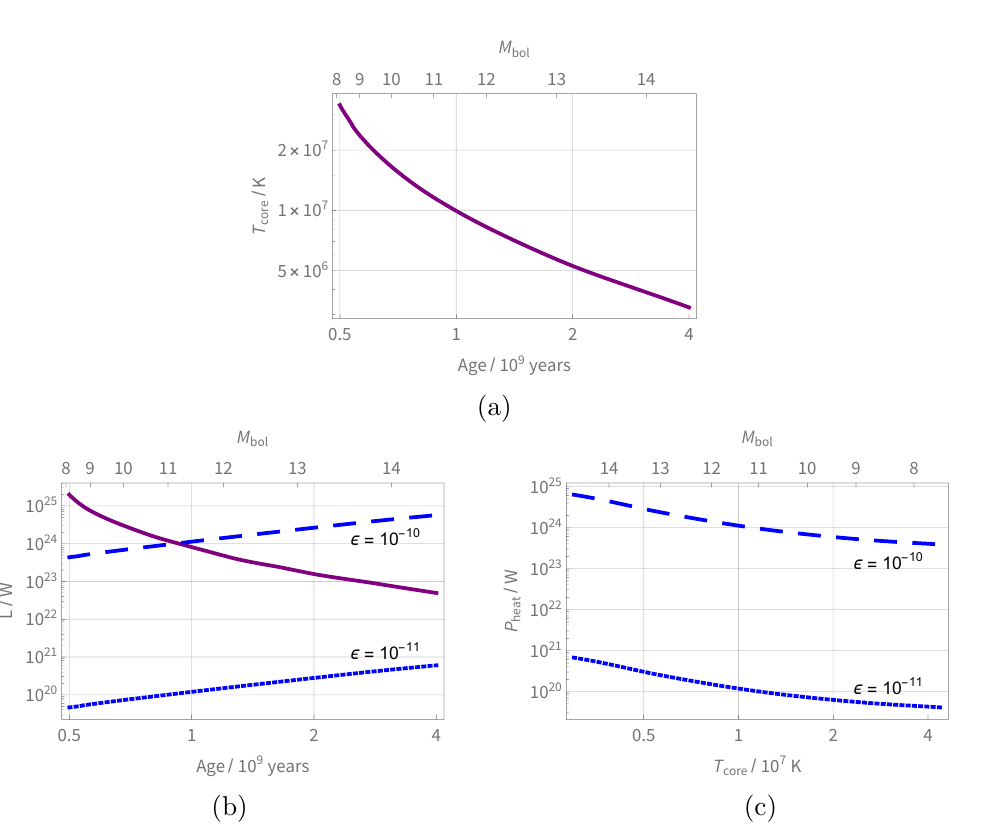
Figure 2 . (a) Core temperature of our benchmark star once it enters the white dwarf phase, as a function of its age or bolometric magnitude. (b) shows the white dwarf energy loss from normal SM photon radiation (purple curve), as well as radiation of dark photons due to the accumulated aDM nugget (under the assumption that the extra cooling does not affect stellar structure). (c) shows the heating rate of the DM nugget as a function of the WD core temperature, to illustrate the surprising result that cooler white dwarfs can actually be more efficient at heating (see section